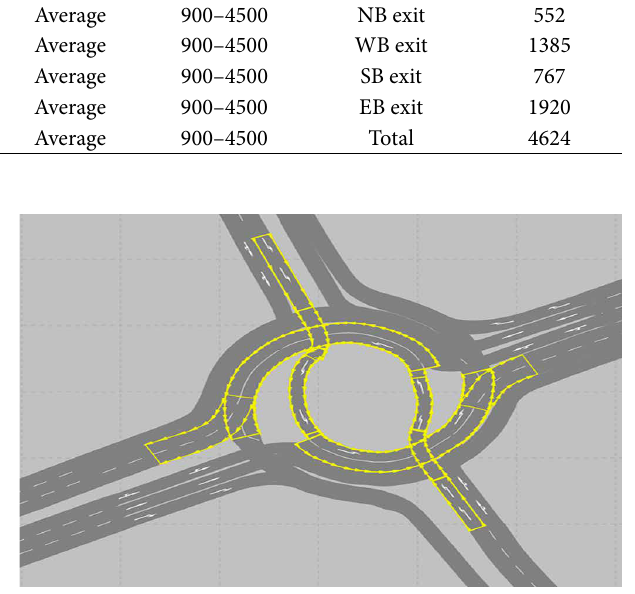
Figure 6: Layout and geometry of the modified rotor roundabout (alternative design